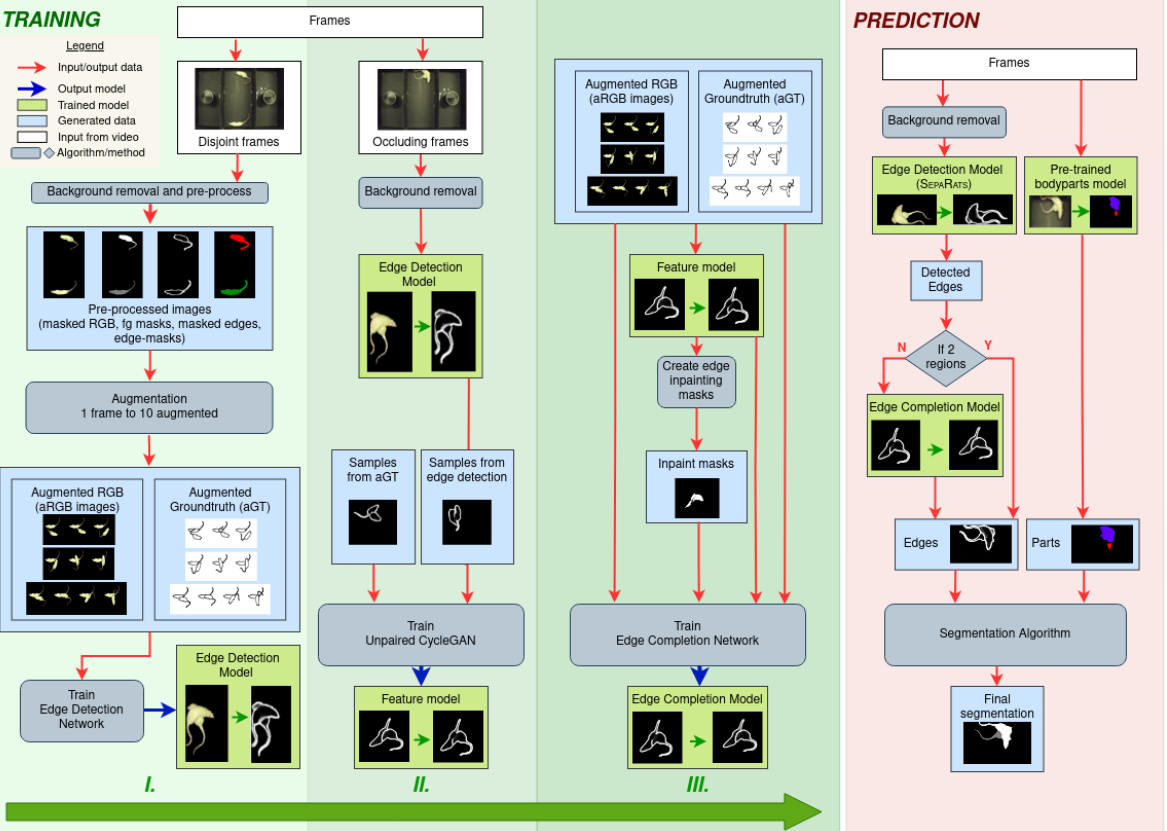
Figure 6. Illustration of the training and prediction pipelines. Three main blocks of the training pipeline: I. synthetic data generation and training Edge Detection model; II. training the Feature Model; III. extending synthetic dataset and training the Edge Completion model. Training is built upon the synthetic data generation. Overlapping inputs and augmented ground truth data are constructed from pre-processed frames with non-occluding instances. Trained Edge Detection network is applied on frames with occluding instances. The unpaired CycleGAN [7] generates training data on the synthetic dataset for training the Edge Completion network. The prediction pipeline applies the Edge Detection model on the foreground of the frames. If the detected edges are not separating the instances, the foreground mask is a single connected region and the trained Edge Completion network “extends” the edges inside the foreground mask. The segmentation algorithm predicts the final segmentation for each frame. The edge regions and the body regions detected by a pre-trained model [8] are combined to provide a reliable segmentation for identity tracking of the highly similar and markerless instances including during heavy overlaps. The proposed pipeline is completely automatic, no human annotation is required. For more details, see